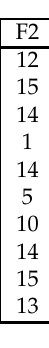
Table 3: The ten pairs of flights with smallest context-aware Fr´echet distances at context weights: 0 (left), 10 (middle), and 20